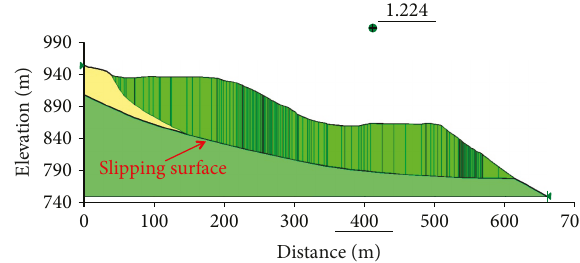
Figure 18: Comparison between simulated and monitored slope water level.